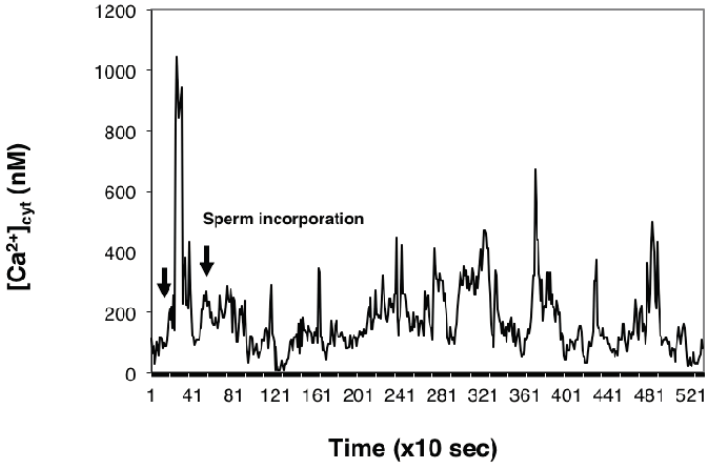
Figure 11. Thapsigargin reduces the amplitude of the sperm-induced transients. Representative [Ca 2+ ] cyt measurement in which an egg cell following incubation in IVF medium containing 2 mM CaCl 2 was treated with 10 μ M thapsigargin and fertilized immediately after the thapsigargin-induced transient increase in [Ca 2+ ] cyt . The first arrow on the left points to the time (7 min) that elapsed from the time of adding thapsigargin to the IVF medium.